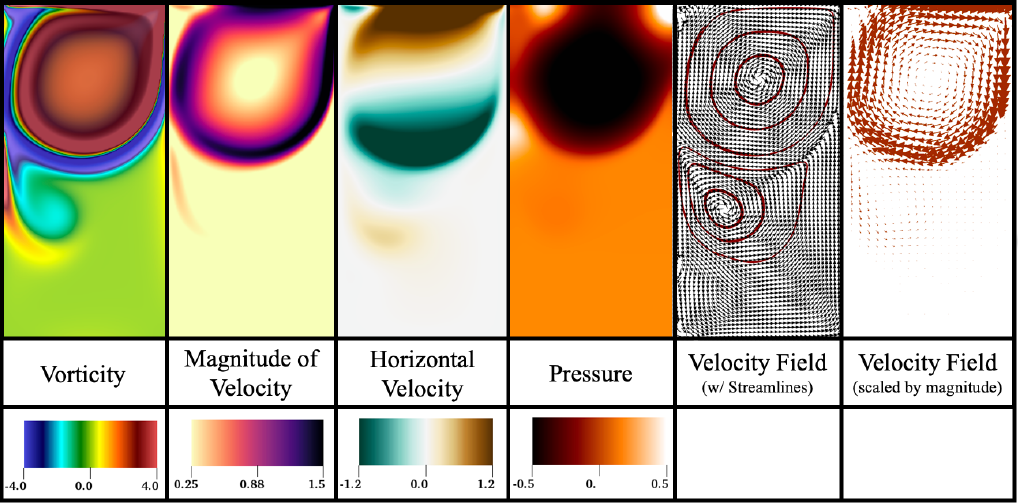
Figure 20. Illustration of all the simulation data produced from the projection method example of cavity flow (at Re = 4000). This snapshot was taken at 6.0 s, as the simulation